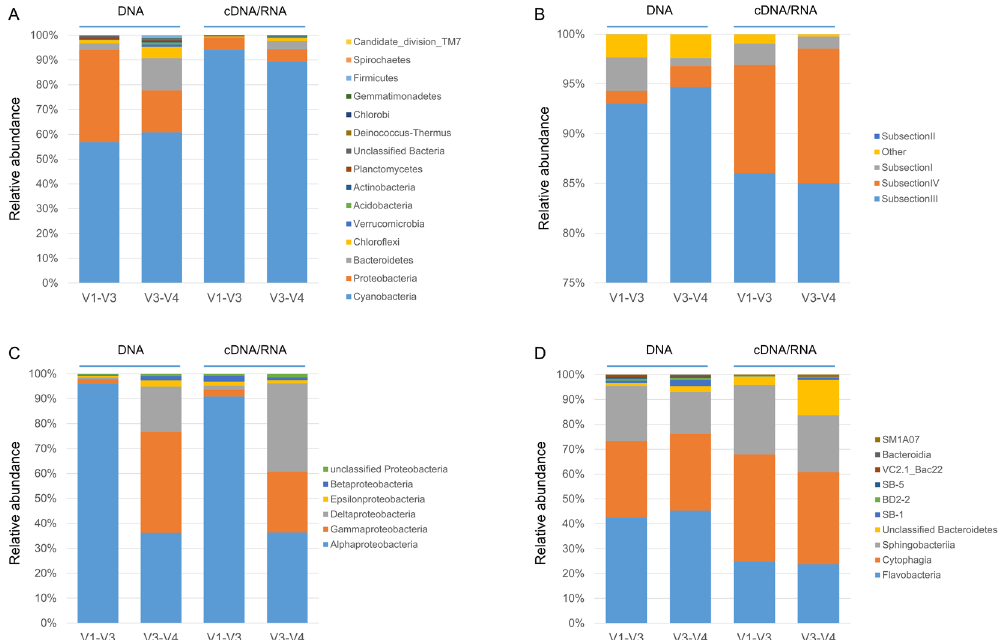
Figure 2. Taxonomic distribution comparison of the four different analysis. ( A ) bacterial phyla, ( B ) cyanobacterial order ( C ) proteobacterial class and ( D ) bacteroidetal class. “Other” represent sequence reads not further assigned within the taxa. The y axes in ( B ) starts at 75% for better representation of the distribution of the cyanobacterial orders. The nucleotide source is presented at the top whereas the amplified 16S region is presented in the x-axis. For large datasets only the dominant taxa were